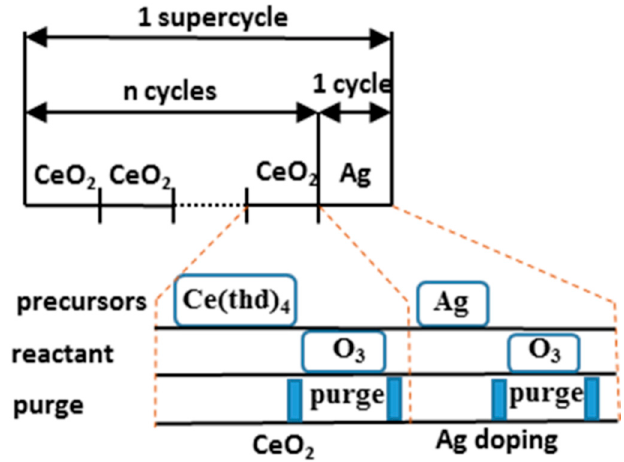
Figure 1. A schematic representation of the atomic layer deposition (ALD) supercycle used to deposit Ag doped CeO 2 catalytic thin films.